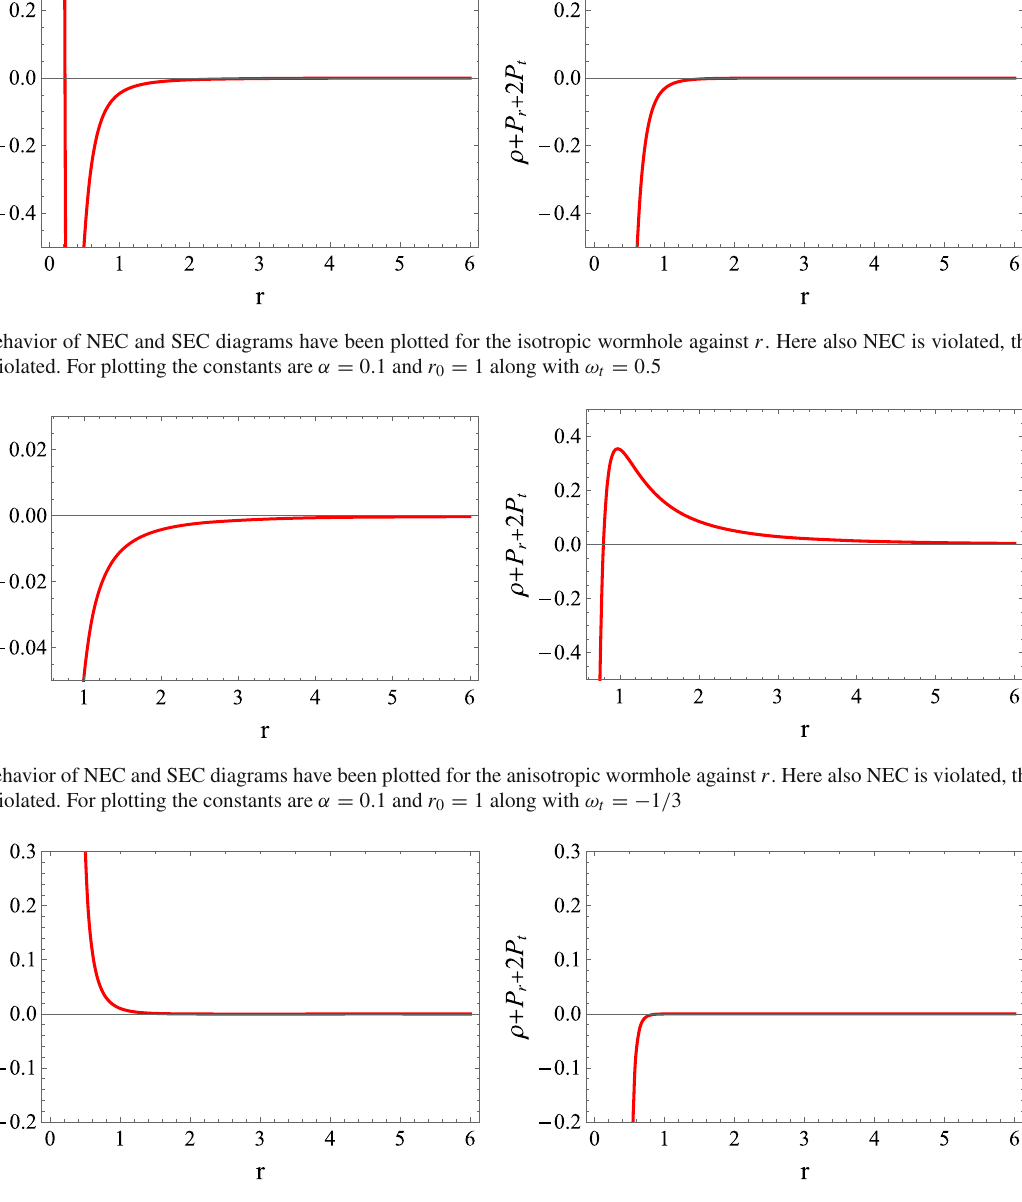
Fig. 7 Plots for NEC (left panel) and SEC diagrams (right panel) against radial coordinate and depending on ρ( r ) = ρ 0 ( r 0 / r ) β . In this cases, NEC is violated outside the throat whereas SEC is violated